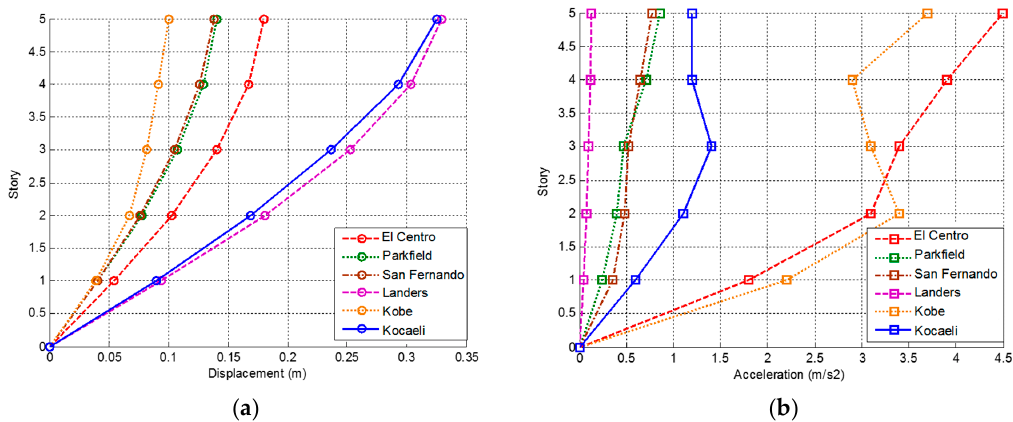
Figure 3. The results of ( a ) peak displacement and ( b ) peak acceleration for different stories of building after changing the story mass.